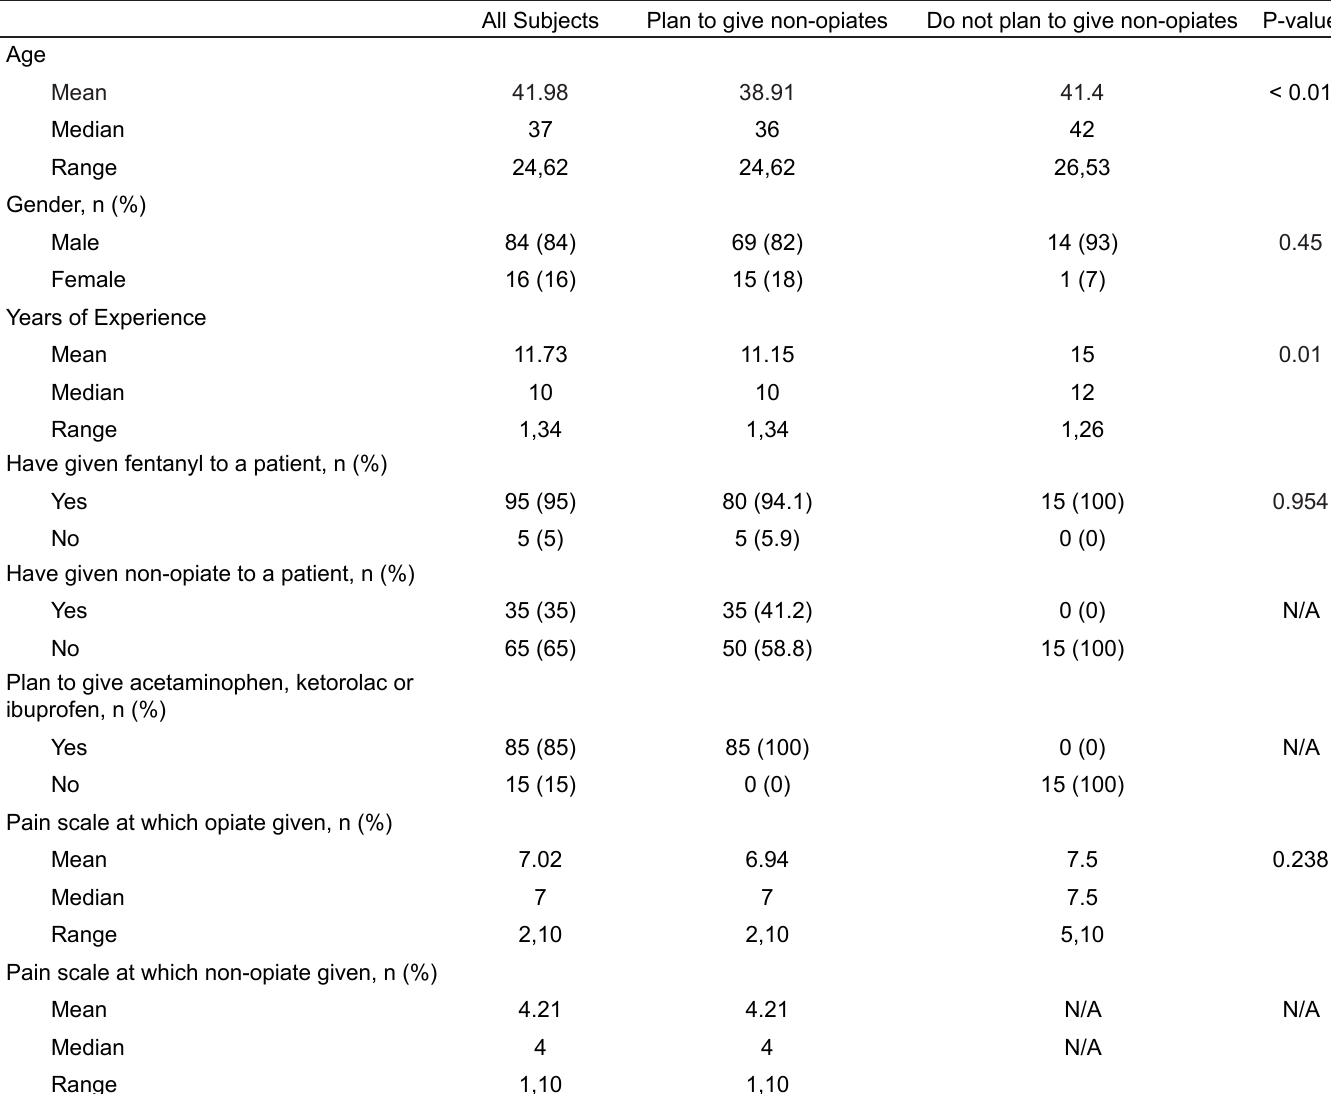
Table 3. Survey respondent